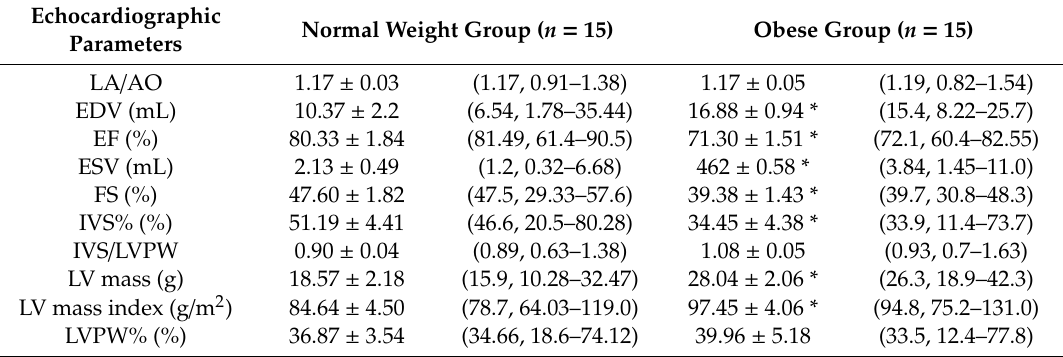
Table 4. Cardiac function from M-mode parameters in normal weight and obese groups. Mean ± SE (median, minimum–maximum) are reported.